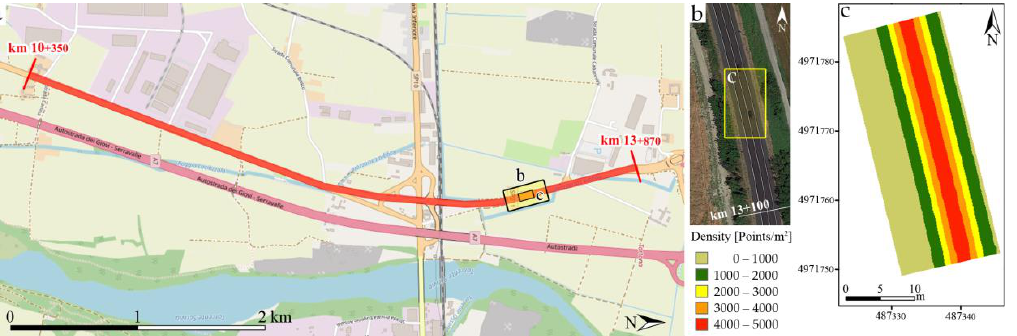
Figure 1. ( a ) Overview of the test site. ( b ) A picture of the section of a secondary suburban road. ( c ) Mobile laser scanner (MLS) cloud density map.